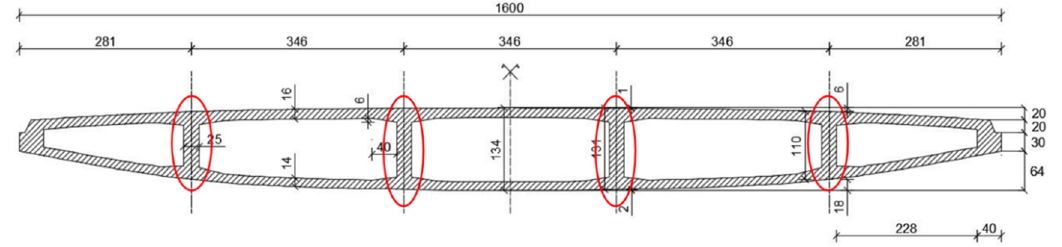
Figure 11. The four effective Gerber saddles (dimensions in cm).